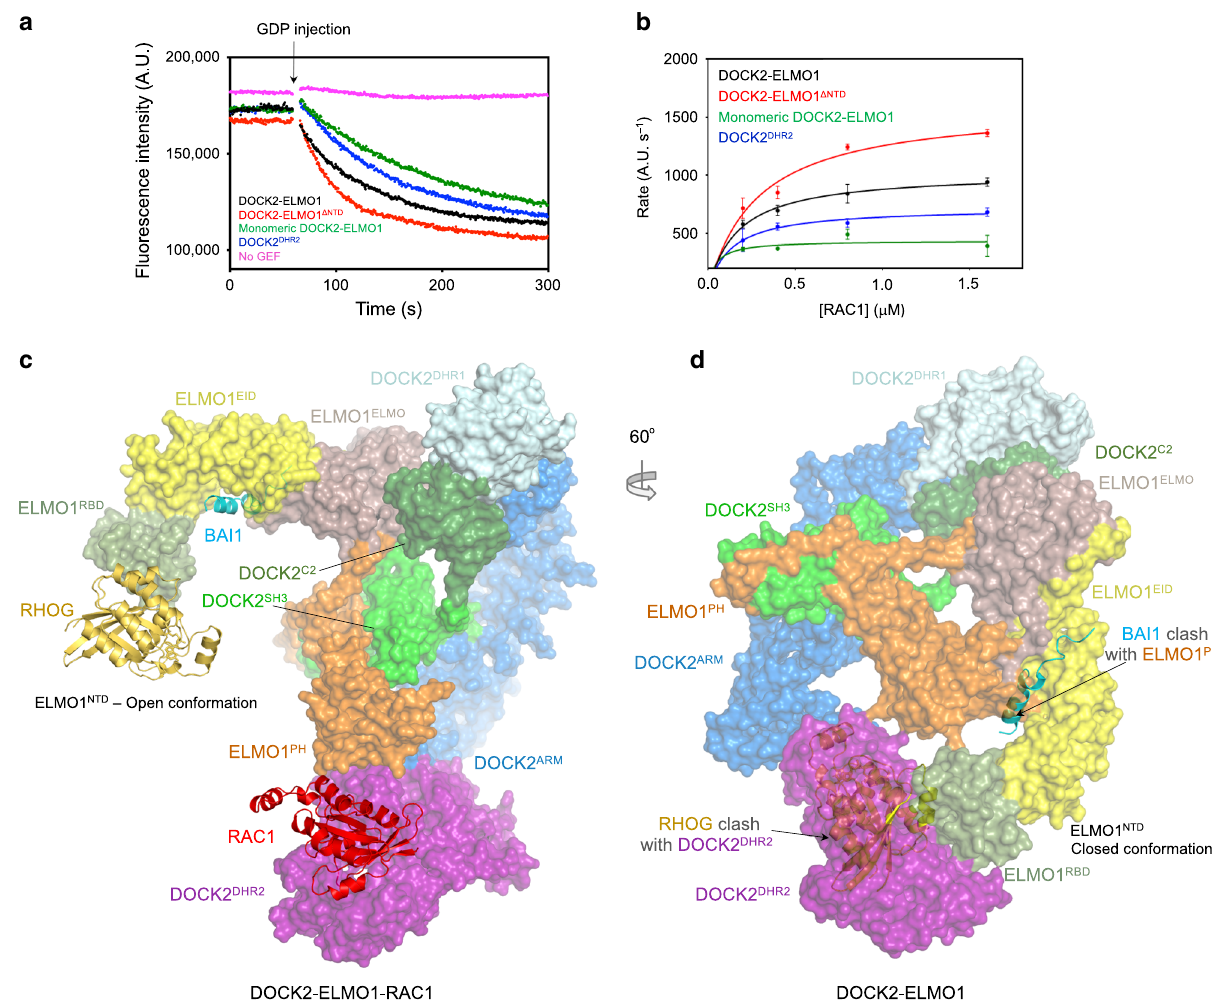
Fig. 6 ELMO1 NTD auto-inhibits DOCK2 – ELMO1. a, b GEF activity data. ELMO1 stimulates DOCK2 GEF activity. Deleting ELMO1 NTD stimulates DOCK2 – ELMO1 GEF activity 60%. Disrupting the DOCK2 dimerization reduces GEF activity by ~60%. a Experimental data for RAC1 at 0.8 μ M. There was no observable spontaneous GDP exchange without the GEF. GEF activity data was monitored by the exchange of fl uorescent mant-GTP following an injection of GDP after 1min (indicated by arrow). b Rates as a function of RAC1 concentration. The initial rates of exchange at increasing substrate (mant-RAC) concentrations were fi tted to a Michaelis-Menten equation with the resultant constants shown in Table 1. Data are presented as mean values with error bars of + / − one standard deviation. The experiment shown in ( a ) and ( b ) was performed six times. c The crystal structure of the RHOG – ELMO2 RBD complex was superimposed onto the modelled ELMO1 RBD of DOCK2 – ELMO1 – RAC1 (shown in surface representation with ELMO1 NTD in the open-conformation). d The crystal structure of the RHOG – ELMO2 RBD complex was superimposed onto ELMO1 RBD of DOCK2 – ELMO1 (shown in surface representation with ELMO1 NTD in